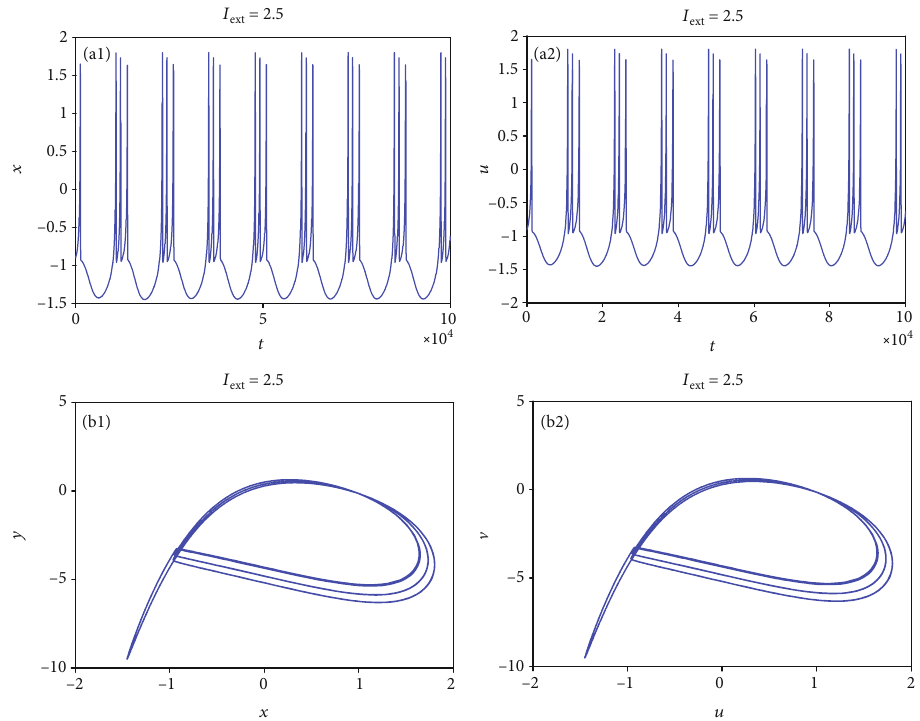
Figure 3: Period-3 fi ring pattern of model (2) when I Phase portraits.